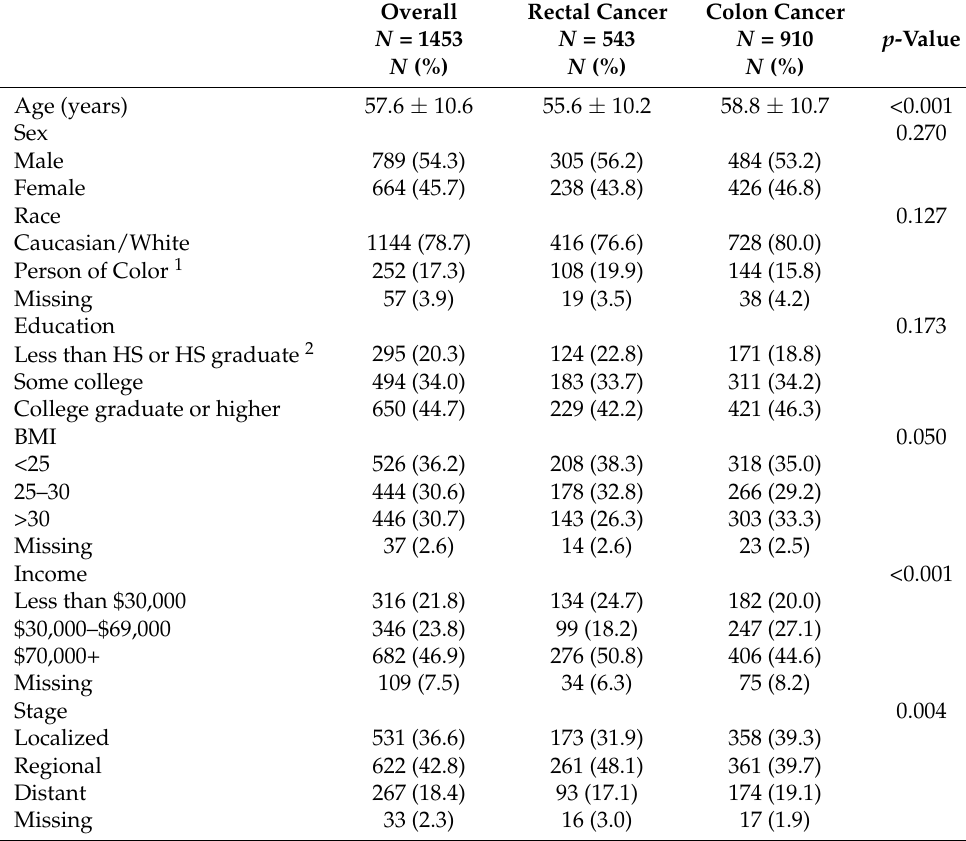
Table 1. Baseline characteristics of colorectal cancer patients by cancer site ( N =